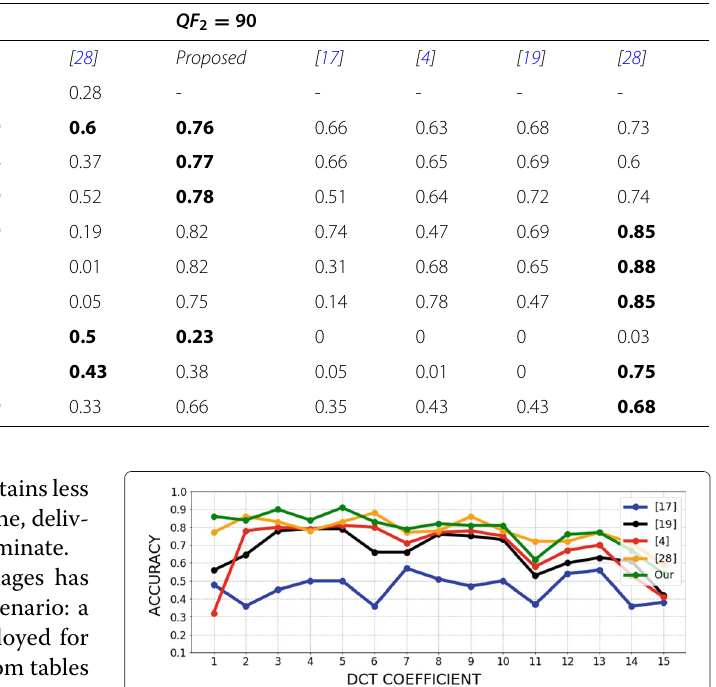
Fig. 2 Average accuracy of the estimation for each DCT coefficient (first is DC) employing standard tables with QF 1 = { 60,65,75,80,85 } and QF 2 = 90. Plot shows results of our method, Bianchi et al. [17], Dalmia et al. [19], Galvan et al. [4] and Niu et al. [28]